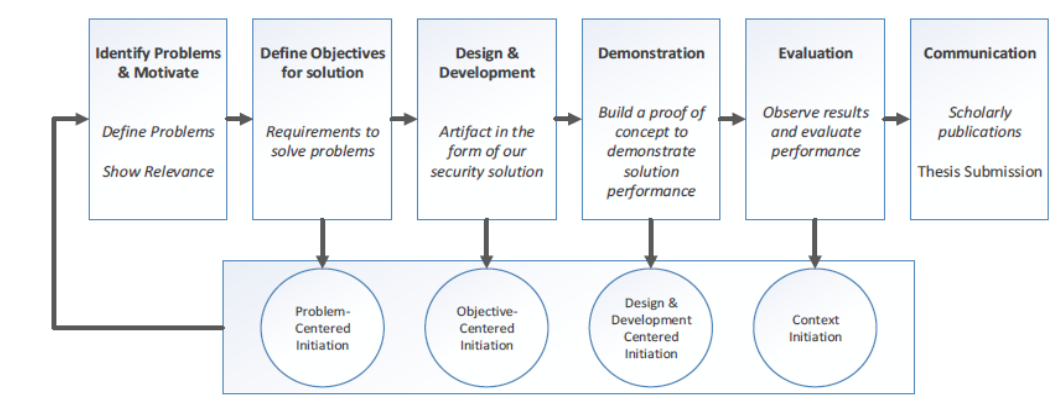
Figure 1. Design Science Research Methodology by Peffers et. al.